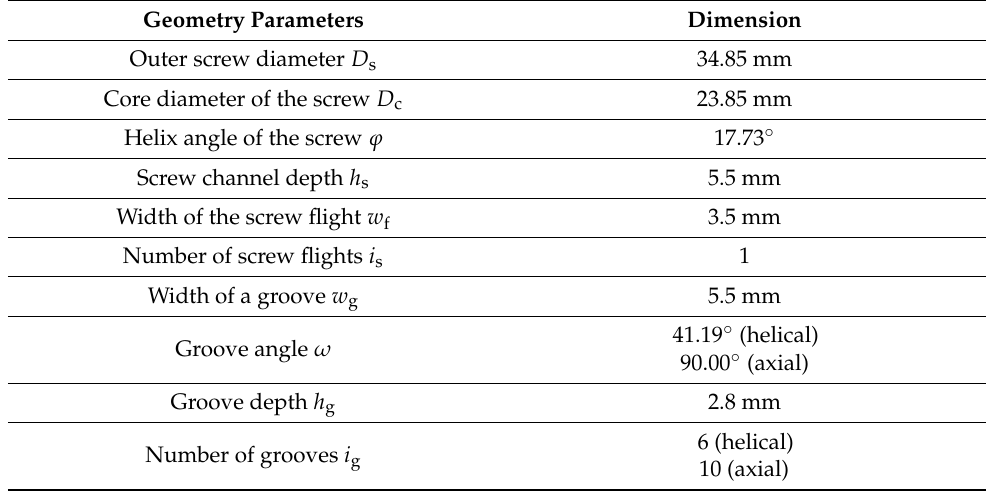
Table 2. Geometrical dimensions of the screw and of the helically and axially grooved